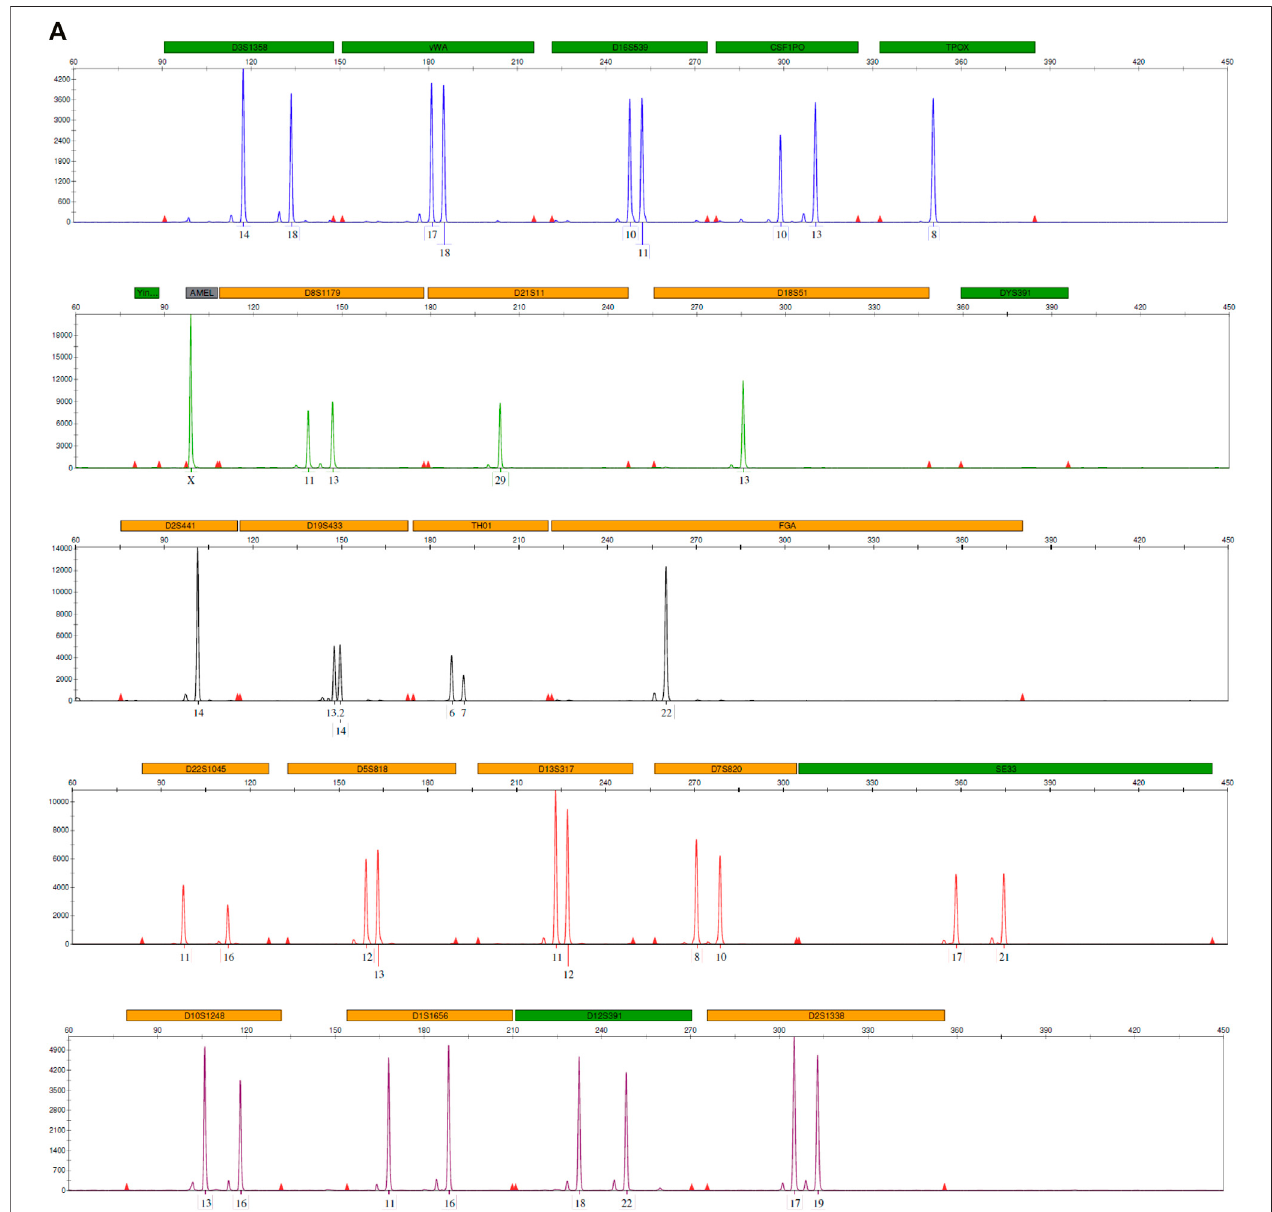
FIGURE 1| STR pro fi les from (A) maternal DNA and (B) asingle fetal cell obtained using the GlobalFiler ™ PCR ampli fi cation kit targeting 24 loci acrossthe human genome, including sex-determining markers, Y indel and Amelogenin. The horizontal panels label the 6-dye, 24-locus STR multiplex after fragment analysis using an ABI3500 genetic analyzer and data analysis using GeneMapper ID-X software (Thermo Fisher Scienti fi c). The marker under each allele peak represents the number of repeats.